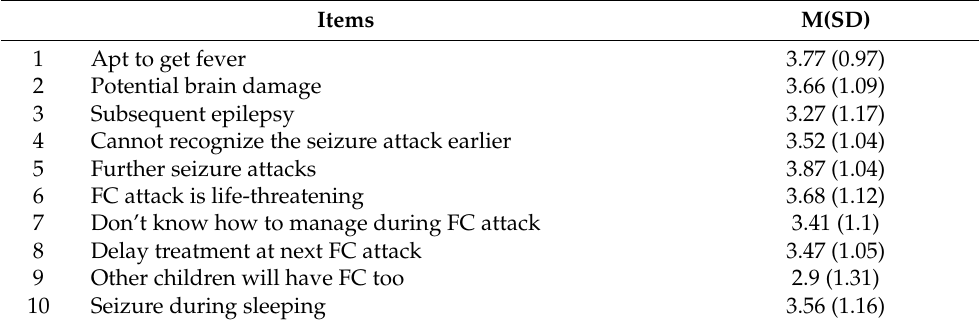
Table A2. Mean Scores of Items of Childcare Providers’ Concerns about FC attack ( n = 216).